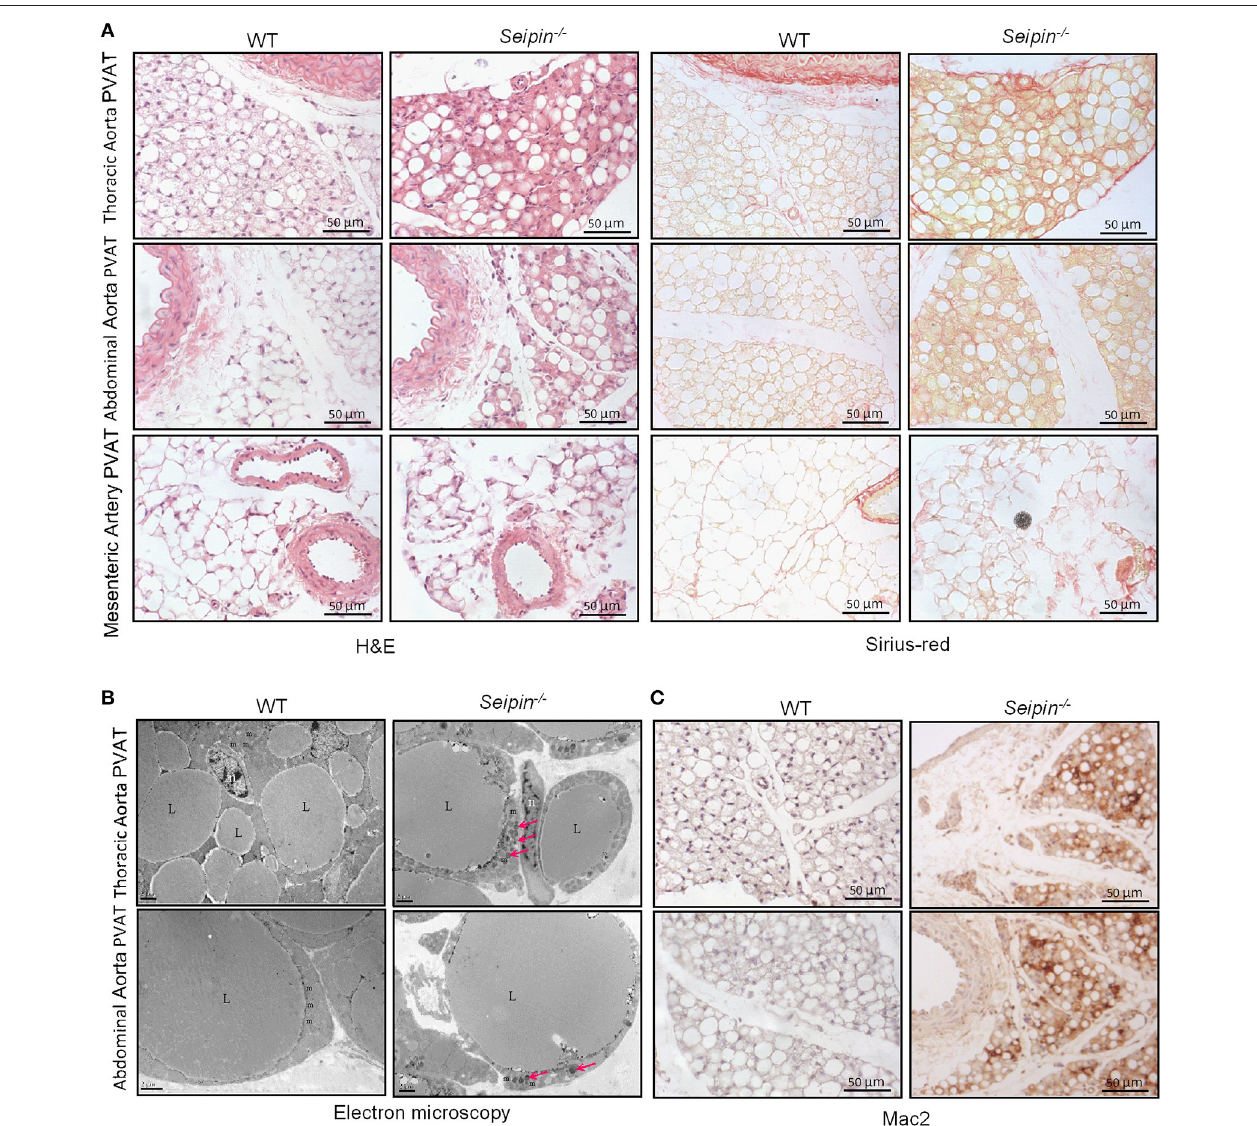
FIGURE 3 | Histological observation of PVAT from WT and Seipin − / − mice. (A) Representative H&E and sirius-red staining of PVAT from 6-month-old WT and Seipin − / − mice. (B) Representative electron microscopy of PVAT from 6-month-old WT and Seipin − / − mice. (C) Mac2 immunostaining of PVAT from 6-month-old WT and Seipin − / − mice. m, mitochondria; n, adipocyte nucleus; L, lipid droplets. Pink arrow indicated deformed